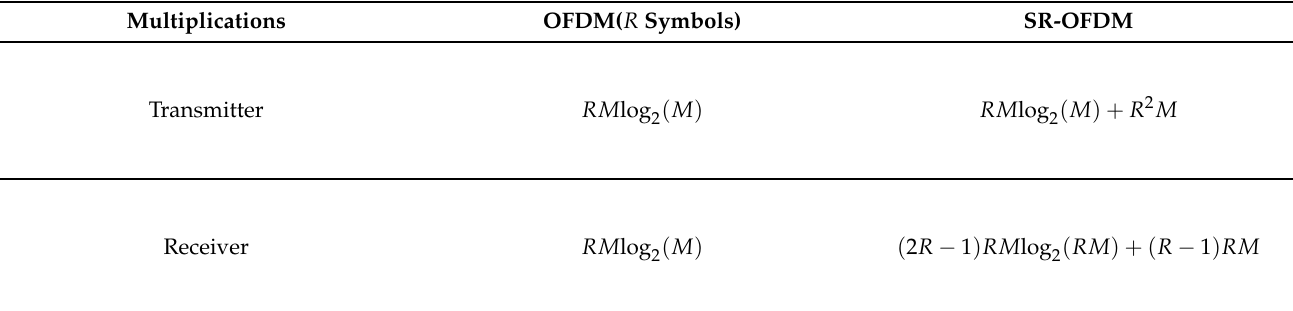
Table 2. Complexity comparison ofthe proposed SR-OFDM and the classical